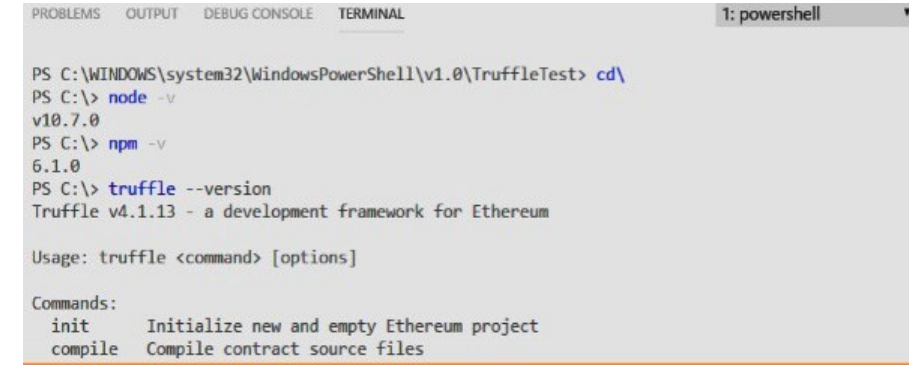
Figure 7. Node.js command prompt.